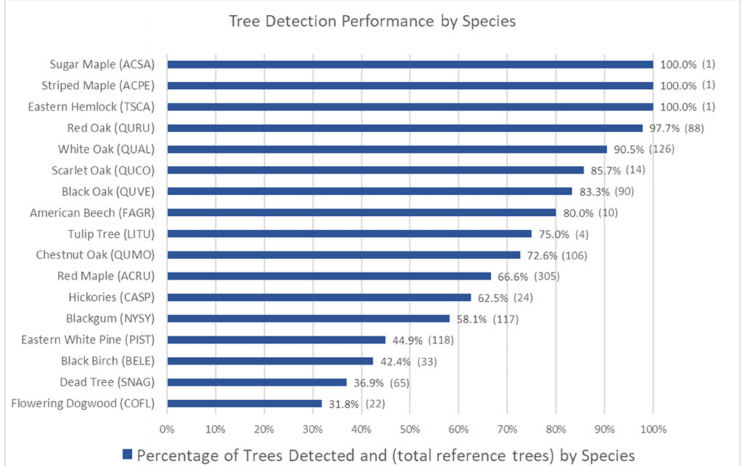
Figure 16. Tree detection performance by species with (tree count). ACSA— Acer saccharum , ACPE— A.